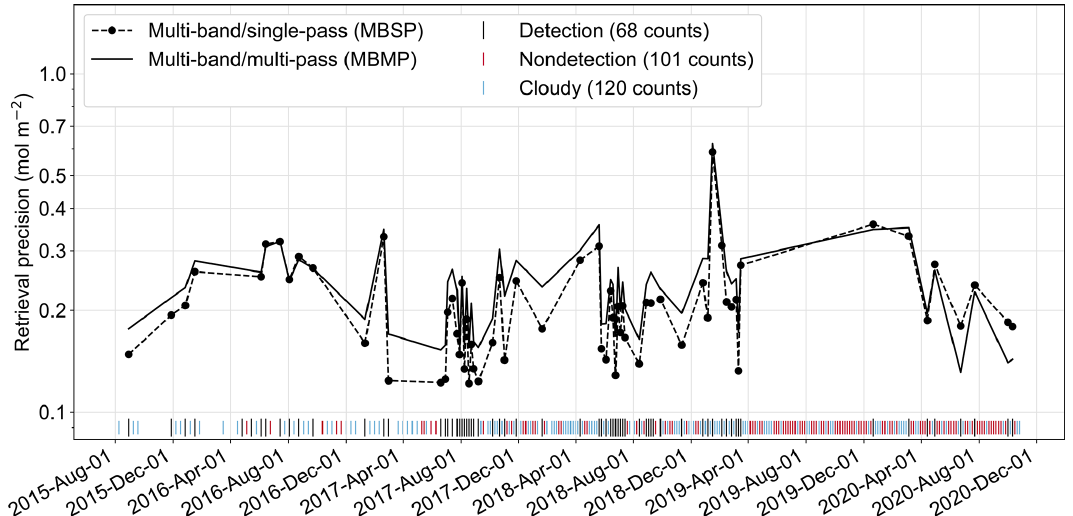
Figure 7. Same as Fig. 5 but for the Korpezhe compressor station point source in Turkmenistan and excluding the SBMP retrieval with very coarse precision.